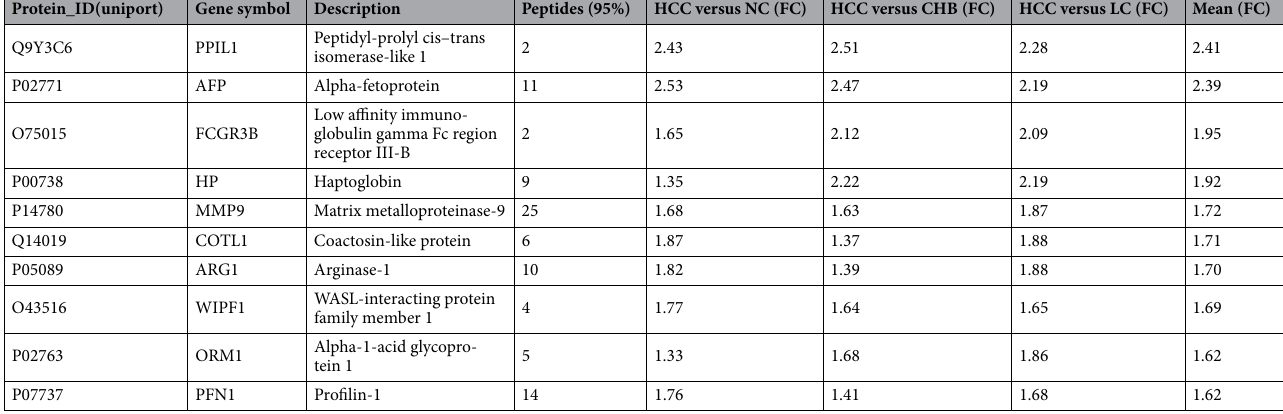
Table 3. The top 10 upregulated differentially expressed proteins. Abbreviations: NC normal control, CHB chronic hepatitis B, LC liver cirrhosis, HCC hepatocellular carcinoma, FC Fold